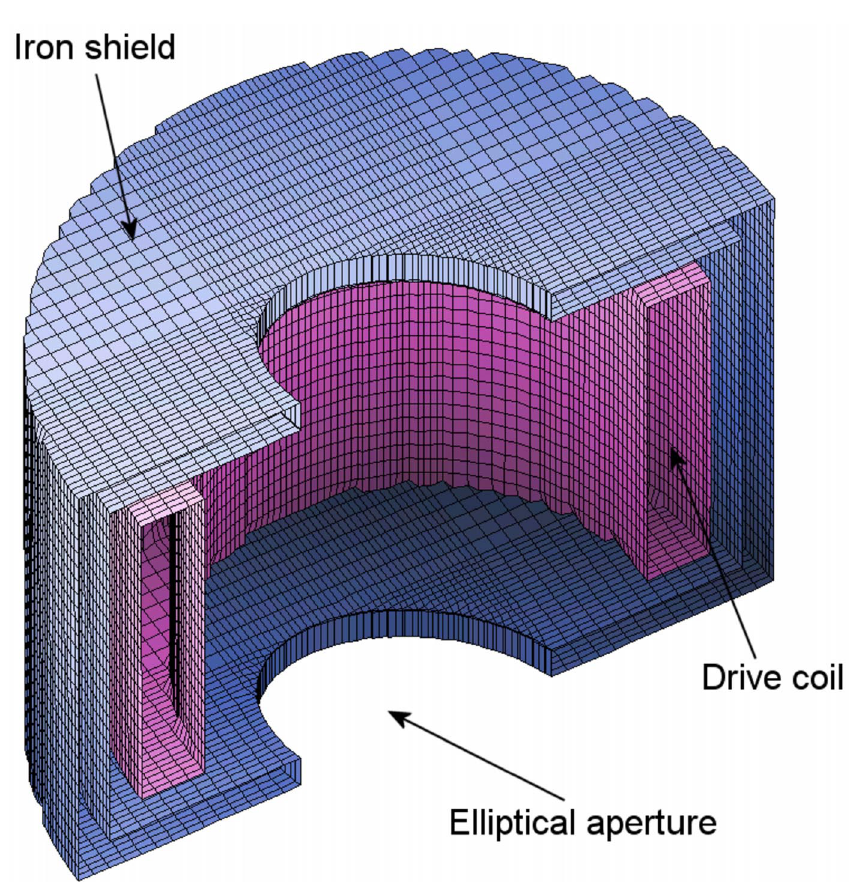
FIG. 1. (Color) Cutaway view of a solenoid lens with elliptical apertures showing the conformal mesh structure for the finite- element field calculation. The elliptical axes are rotated so that the exit beam is parallel to the x - y axes of the simulation.